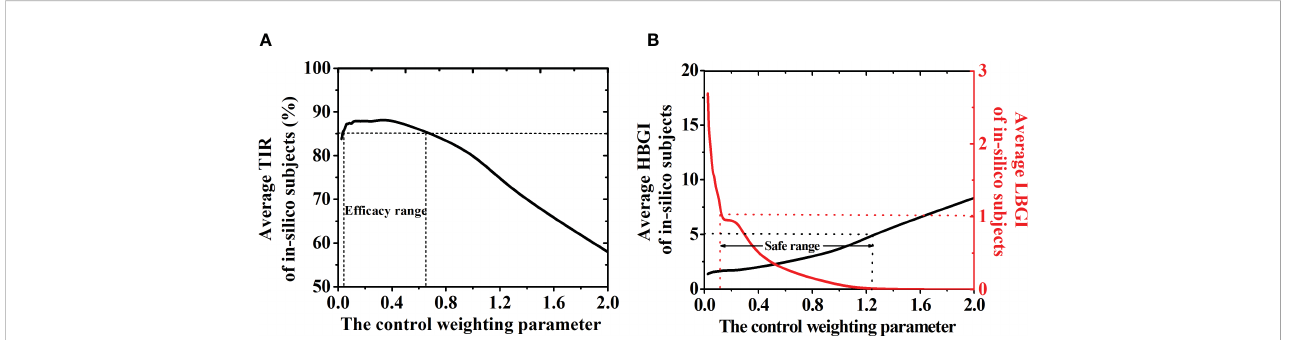
FIGURE 2 (A) TIR of the patient group with different control weighting parameter ( L ). The dotted lines represent the ef fi cacy range of L (0.025 to 0.5), in which the TIR of the patient group is above 85%. (B) HBGI (black line) and LBGI (red line) values of the patient group with different L . The dotted lines represent the safe range of the control weighting parameter (0.125 to 1.25), in which the LBGI< 1.1 and HBGI<5.0. Thus, the selection range of the control weighting parameter should be 0.125 to